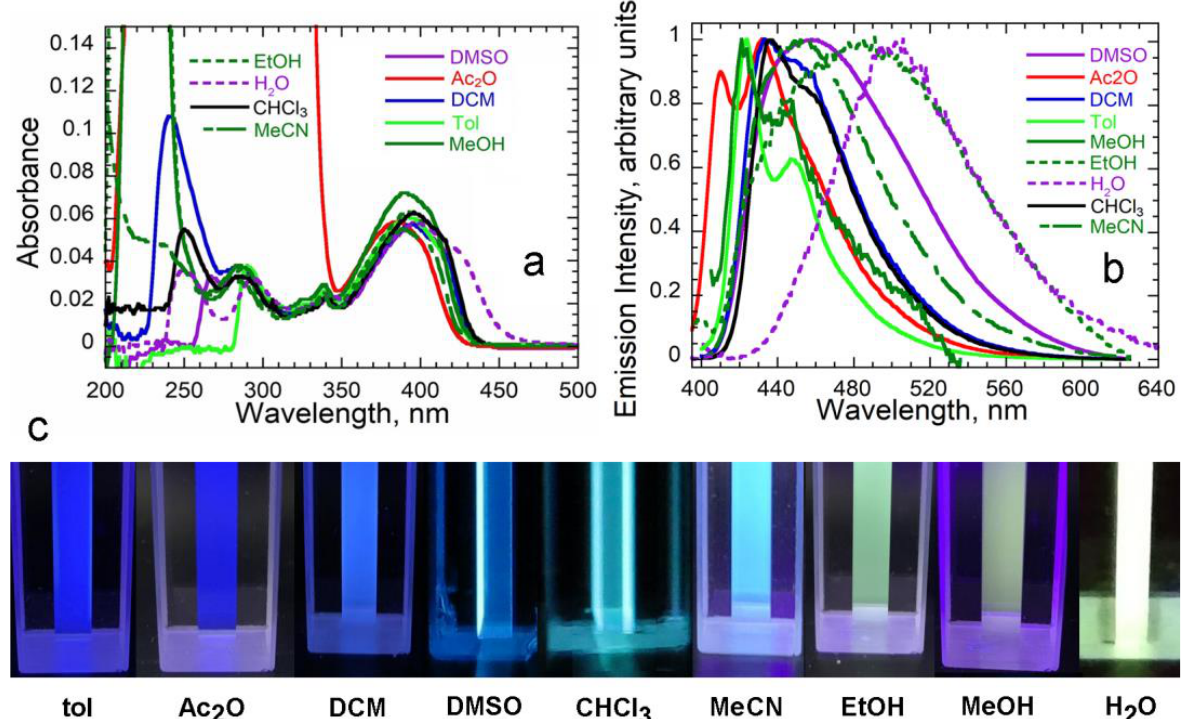
Figure 4. Spectral Behavior of 5 in various organic solvents. ( a ) Absorbance spectra at 1 um at 25 °C. ( b ) Normalized emission spectra at 1 uM. Excitation wavelength at absorption maxima and slit widths set to 0.8 nm. ( c ) Images of 5 in various solvents upon excitation at 395 nm. H 2 O refers to 10 mM Tris, pH 8.